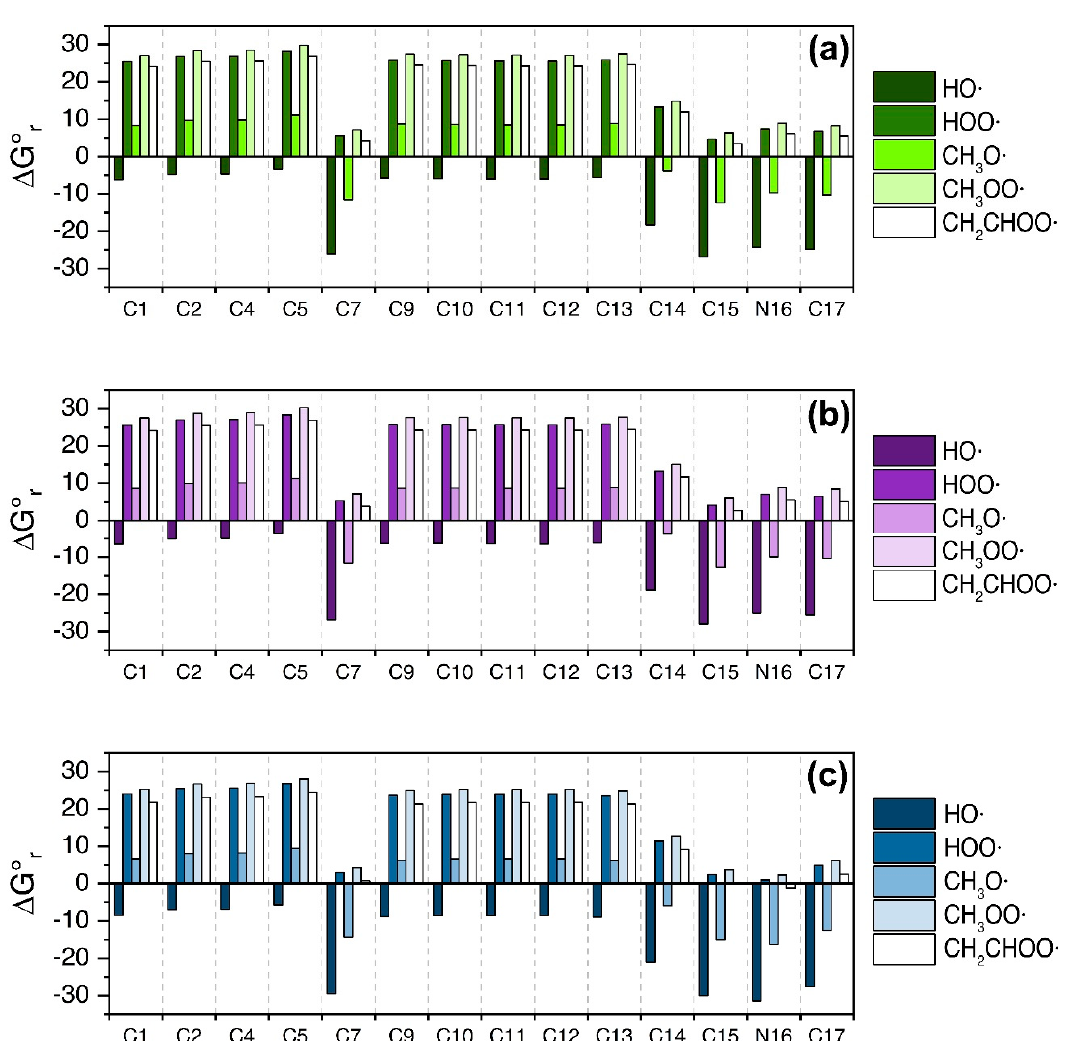
Figure 3. ∆ G ◦ HAT (kcal mol − 1 ) in the gas phase ( a ), in benzene ( b ), and in water ( c ) for the scavenging of HO • , CH 3 O • , HOO • , CH 3 OO • , and CH 2 = CHOO • through HAT from all the available sites of 1 . Level of theory: (SMD)-M06-2X / 6-311 + G(d,p) // M06-2X / 6-31G(d). Table 1. ∆ G ‡ HAT (kcal mol − 1 ) in the gas phase, benzene, and water, for the scavenging of HO •